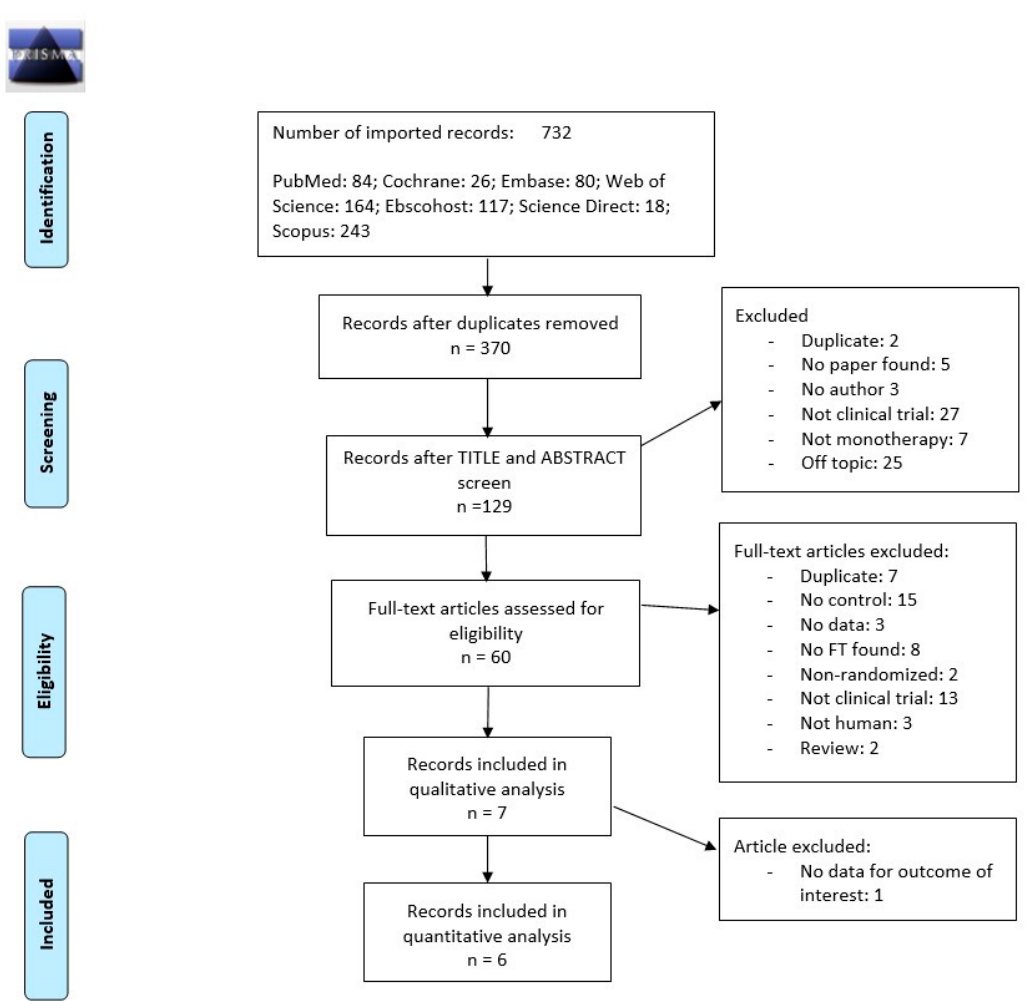
Figure 1. Flowchart illustrate the screening process for the inclusion of eligible studies for meta- analysis.